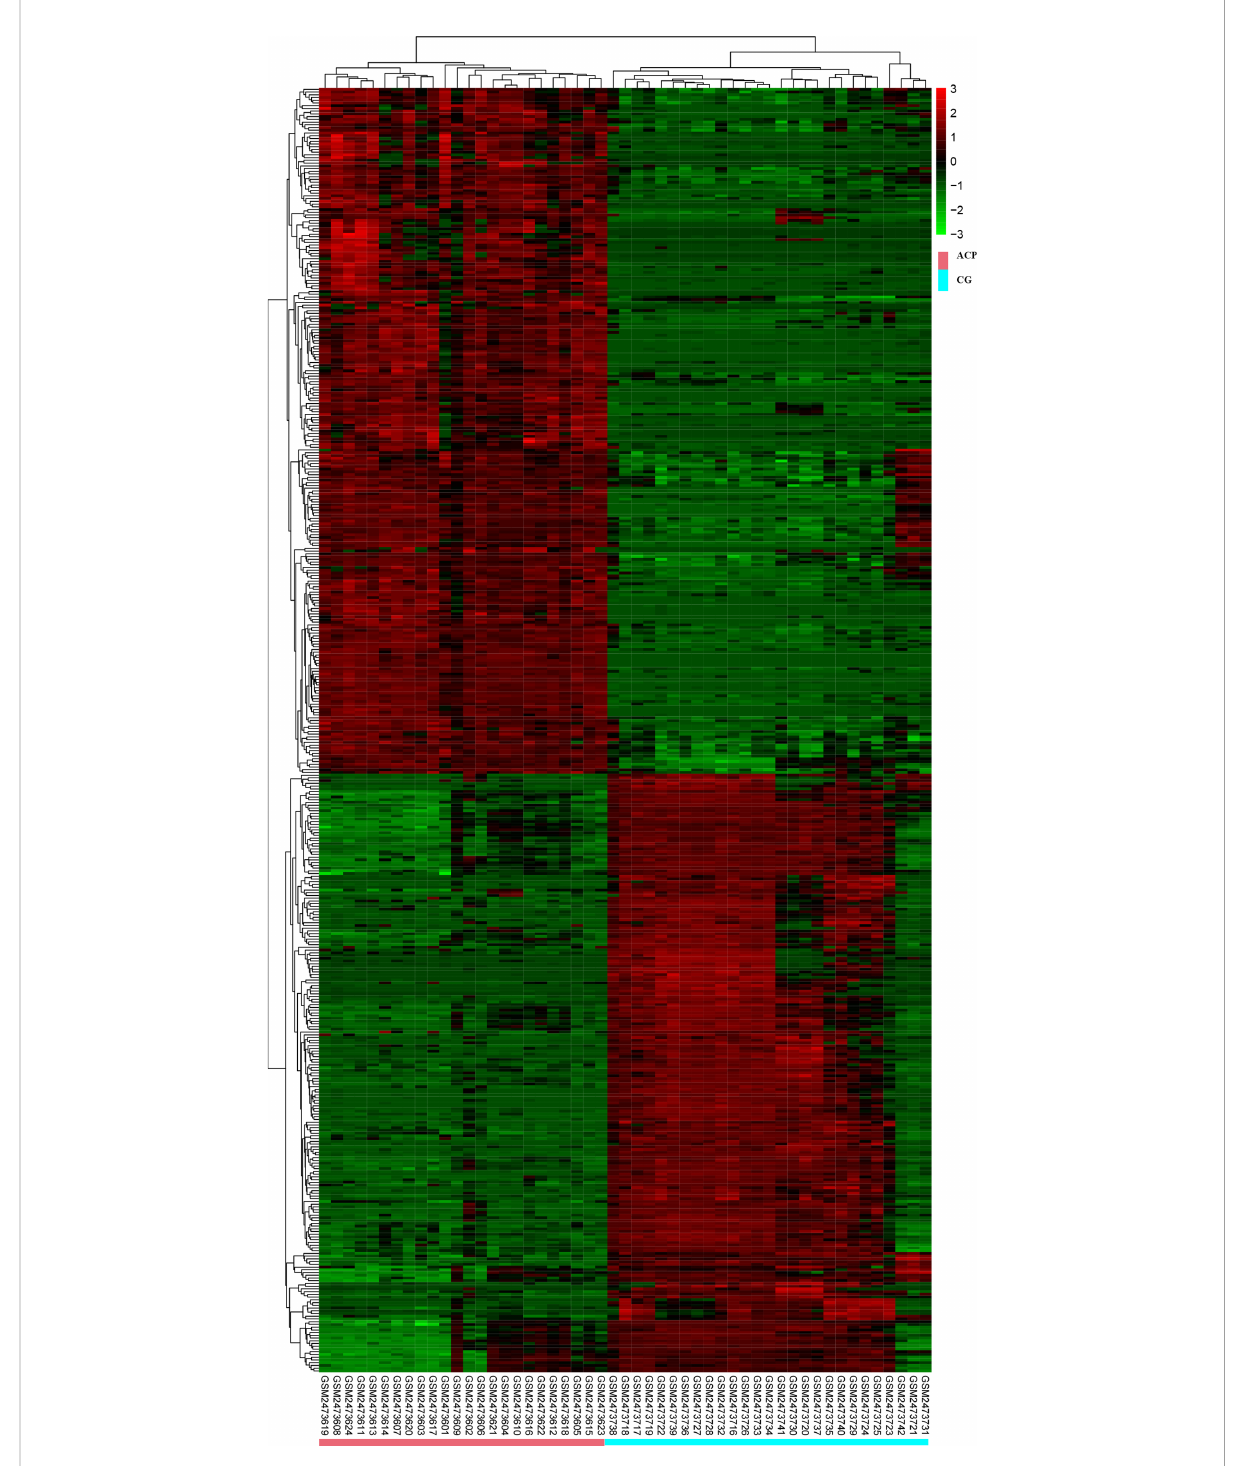
FIGURE 2 Hierarchical cluster analysis could accurately distinguish ACP samples from control samples. CGs, individuals with no documented tumor complication samples; ACP, adamantinomatous